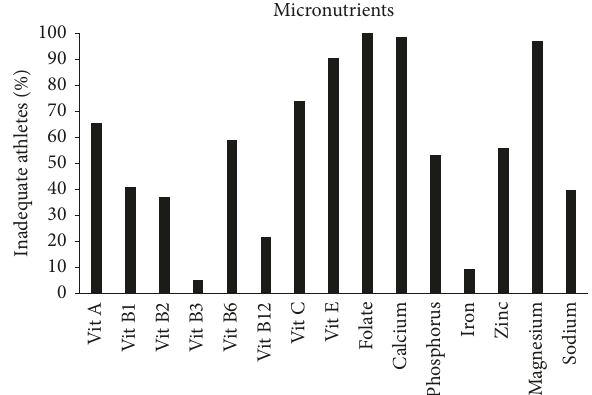
Figure 1: Prevalence of inadequacy in micronutrients ( n